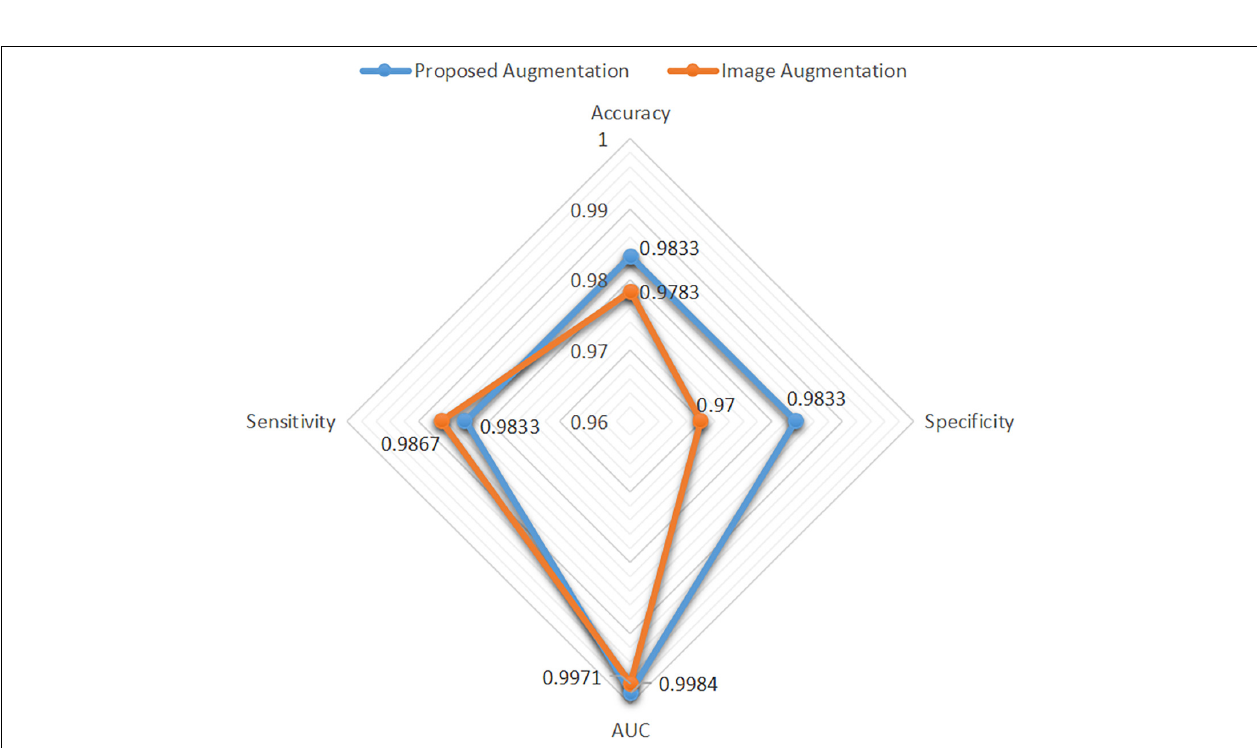
FIGURE 9 | Performance difference between the proposed augmentation and image